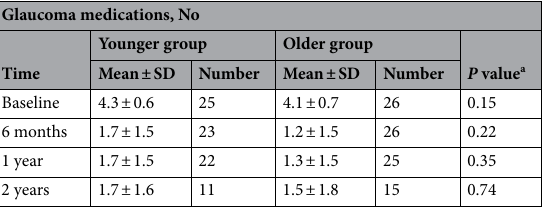
Table 5. The number of glaucoma medications during follow-ups after BGI. BGI Baerveldt glaucoma implant, SD standard deviation. a Mann–Whitney U test.